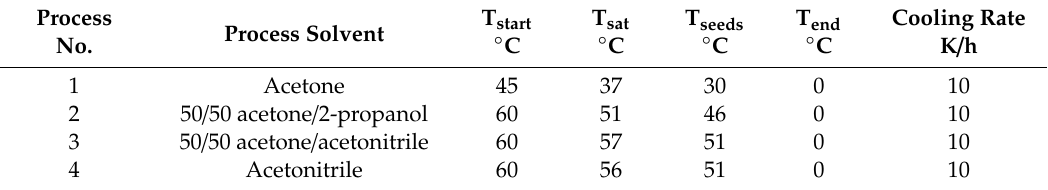
Table 4. Overview of the selected crystallization process